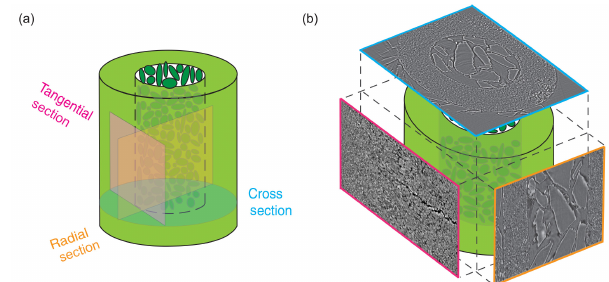
Figure 2. Illustration of sample configuration. (a) The sample is composed a sintered olivine aggregate cup with loose olivine sand fillings (grain size 100–500µm). Quantitative microtomographic analyses are conducted on the tangential (pink), radial (orange) and cross (blue) section of the sample. (b) Example of the tomographic image that was used in the 2-D examination of Zhu et al.